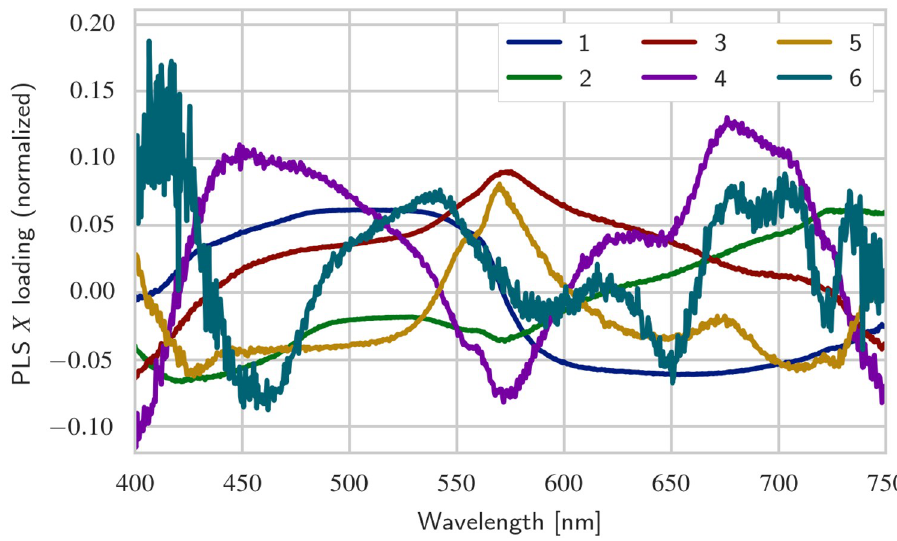
Fig 7. PLS X loadings for orange corals. Same as Fig 6, but created using data from orange corals. A notable difference is the significant noise in loading 6, indicating that explanatory power is decreasing at this